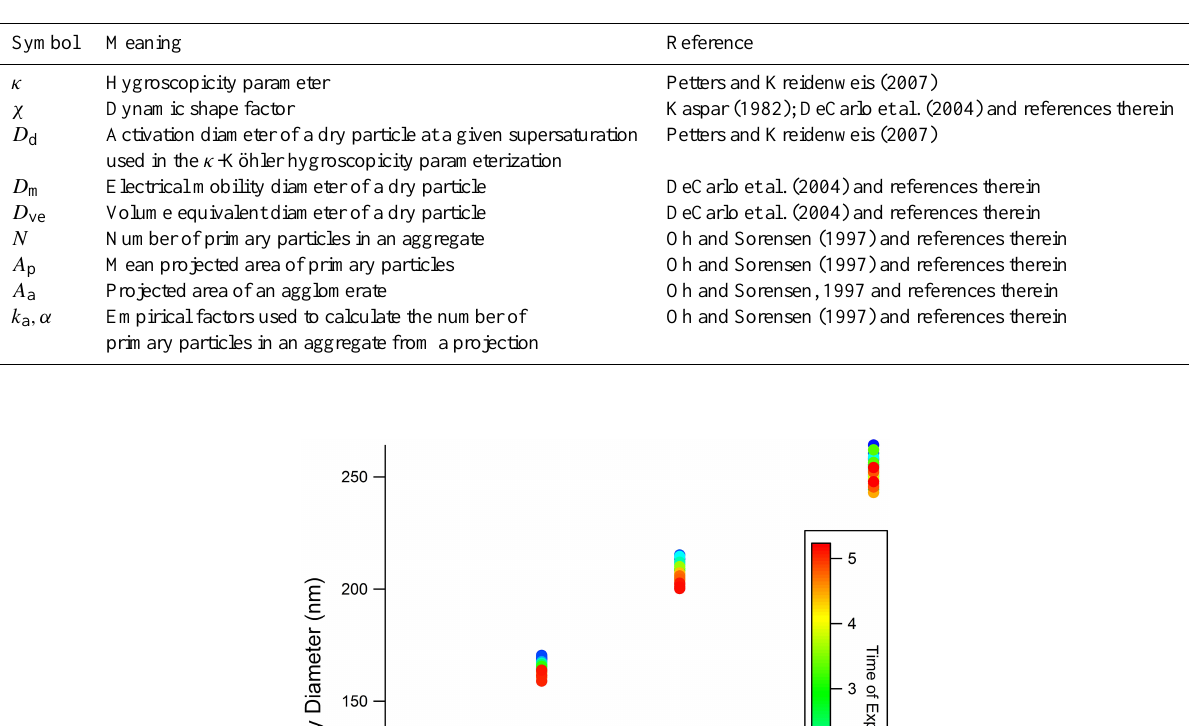
Table A2. Summary and definition of key symbols.